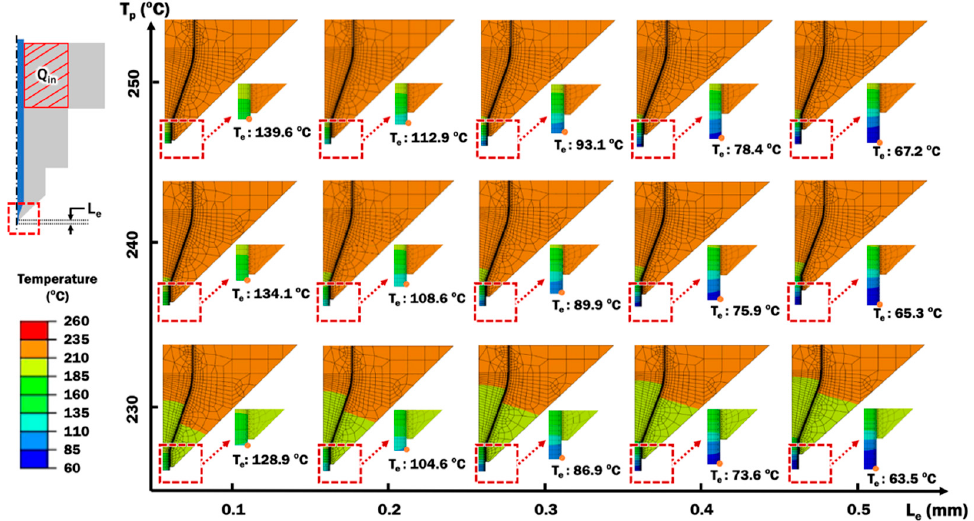
Figure 9. Estimated temperature distributions of PLA material from heat transfer analysis using different combinations of printing temperatures and extruded length of filament from the end of the nozzle orifice.